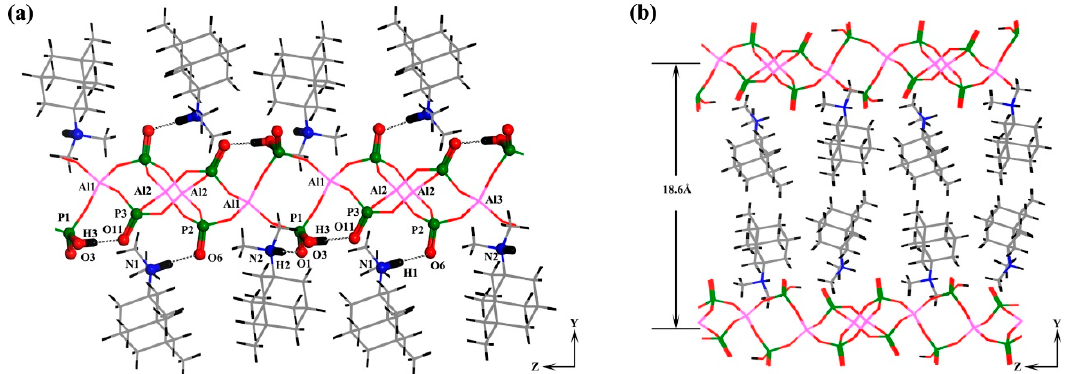
Figure 4. ( a ) A view of the intra-layer and inter-layer hydrogen-bond interactions; ( b ) Two layers of organic structure-directing agent (OSDA) molecules separate the aluminophosphate layers.